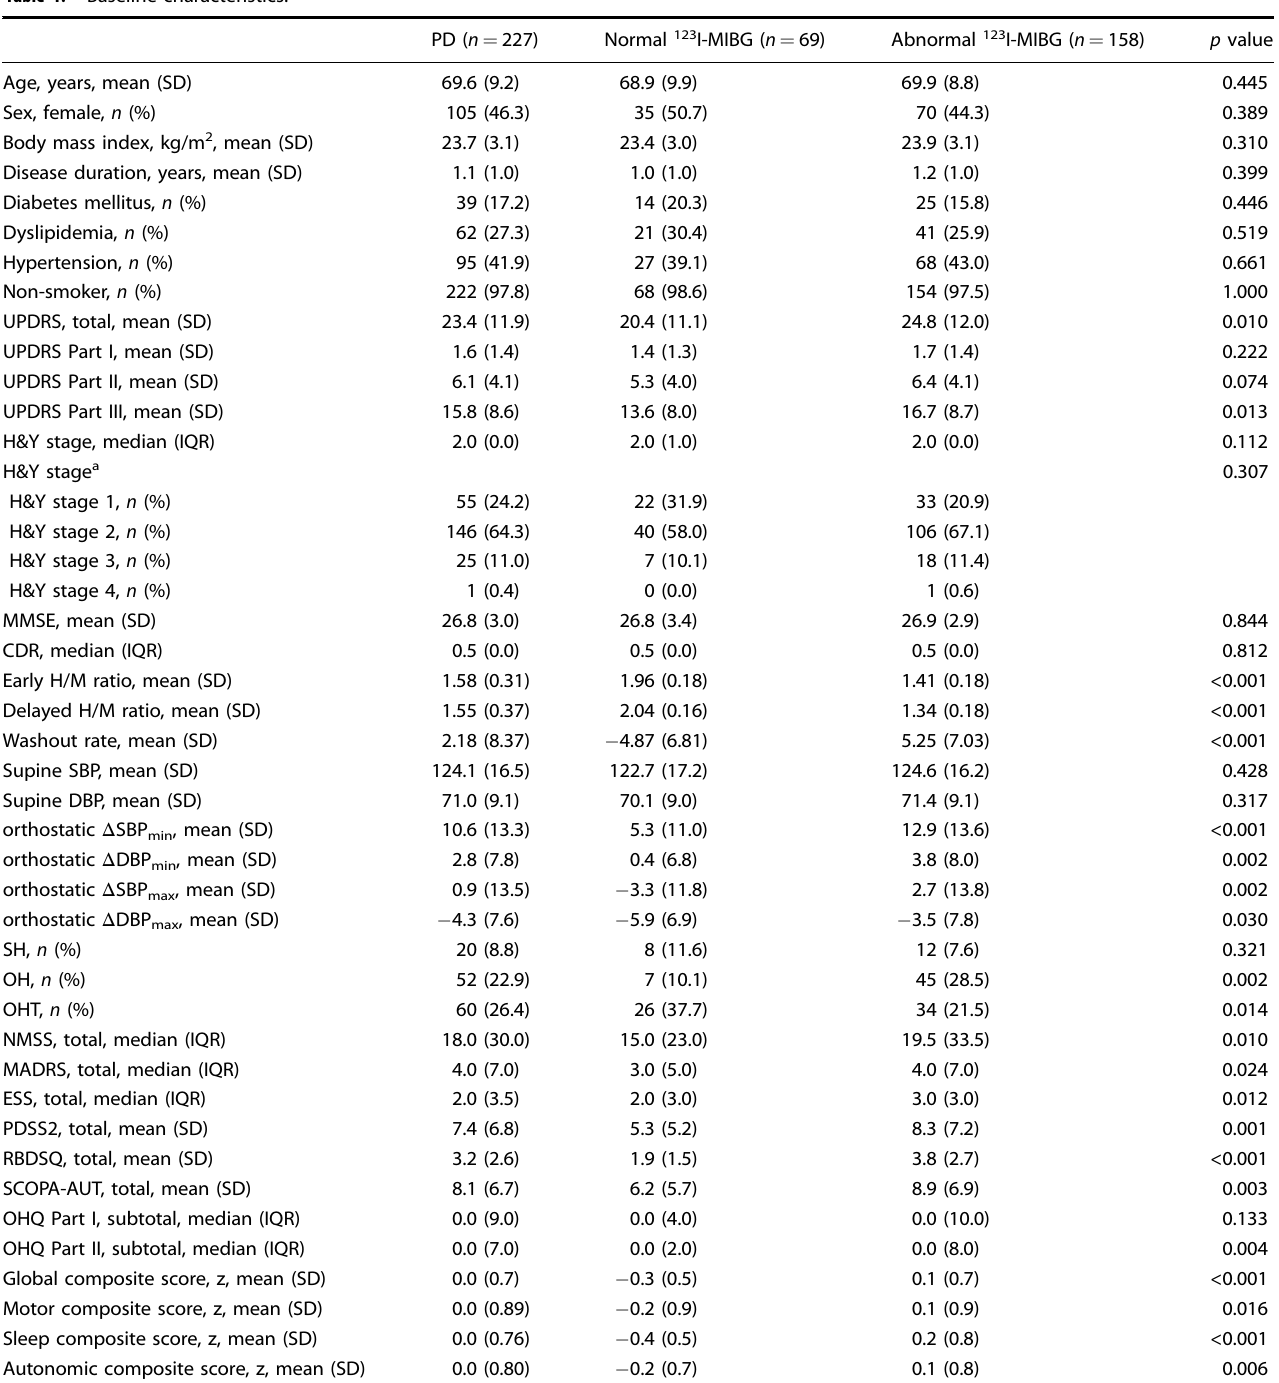
Table 1. Baseline